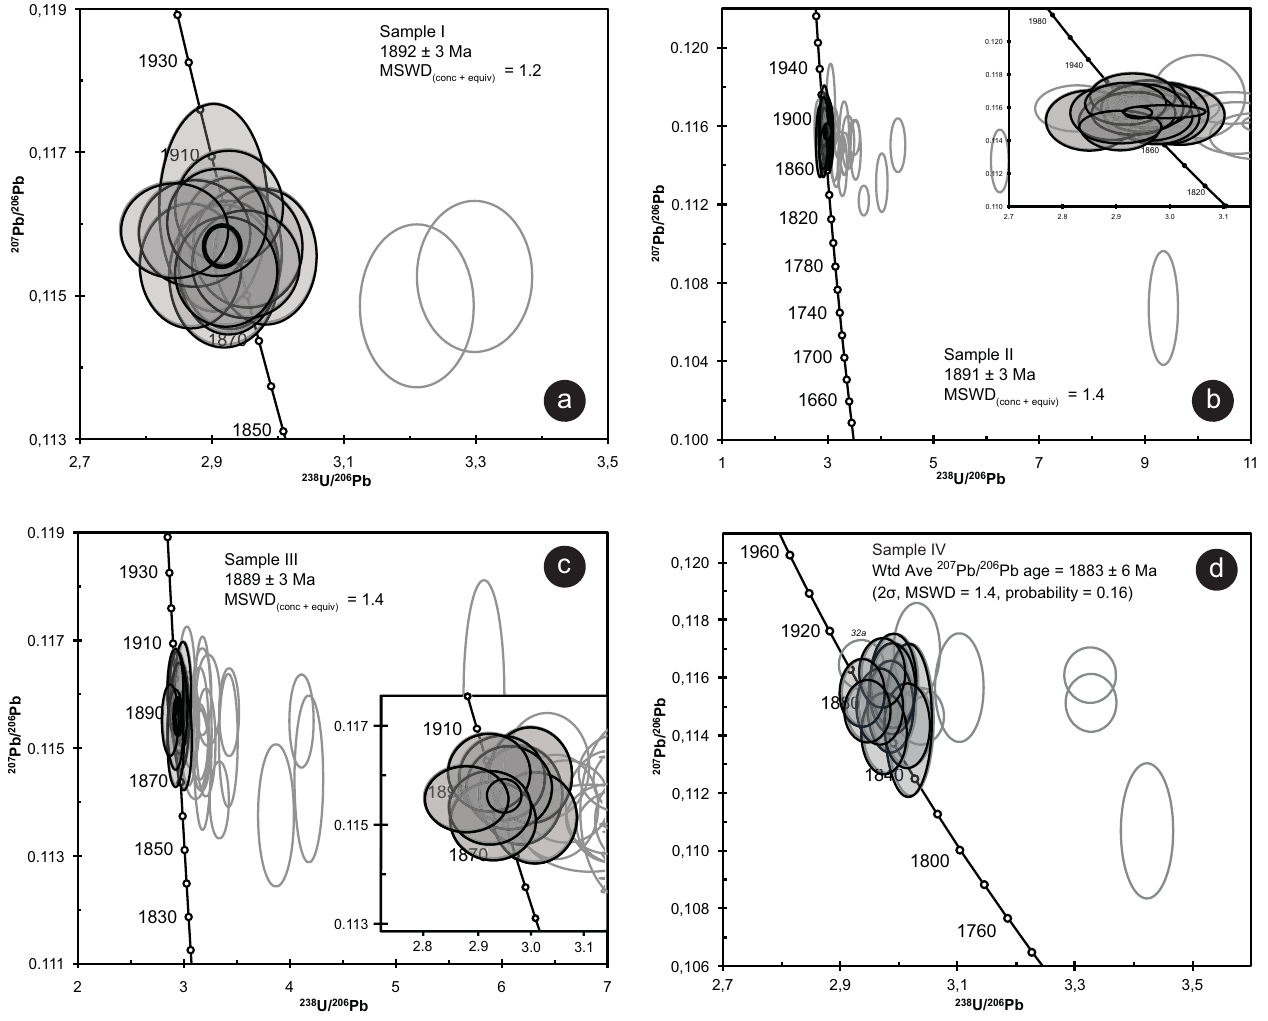
Fig. 6. Tera-Wasserburg type concordia diagrams for the dated rock units. (a) Sample I: Viterliden hornblende-tonalite (47.1-pmsk-09), (b) Sample II: Viterliden plagioclase porphyritic tonalite (33.1-pmsk-08), (c) Sample III: quartz-plagioclase porphyritic tonalite (coarse “mine porphyry”; 29.1-pmsk-08), (d) Sample IV: Kristineberg hanging-wall rhyolite